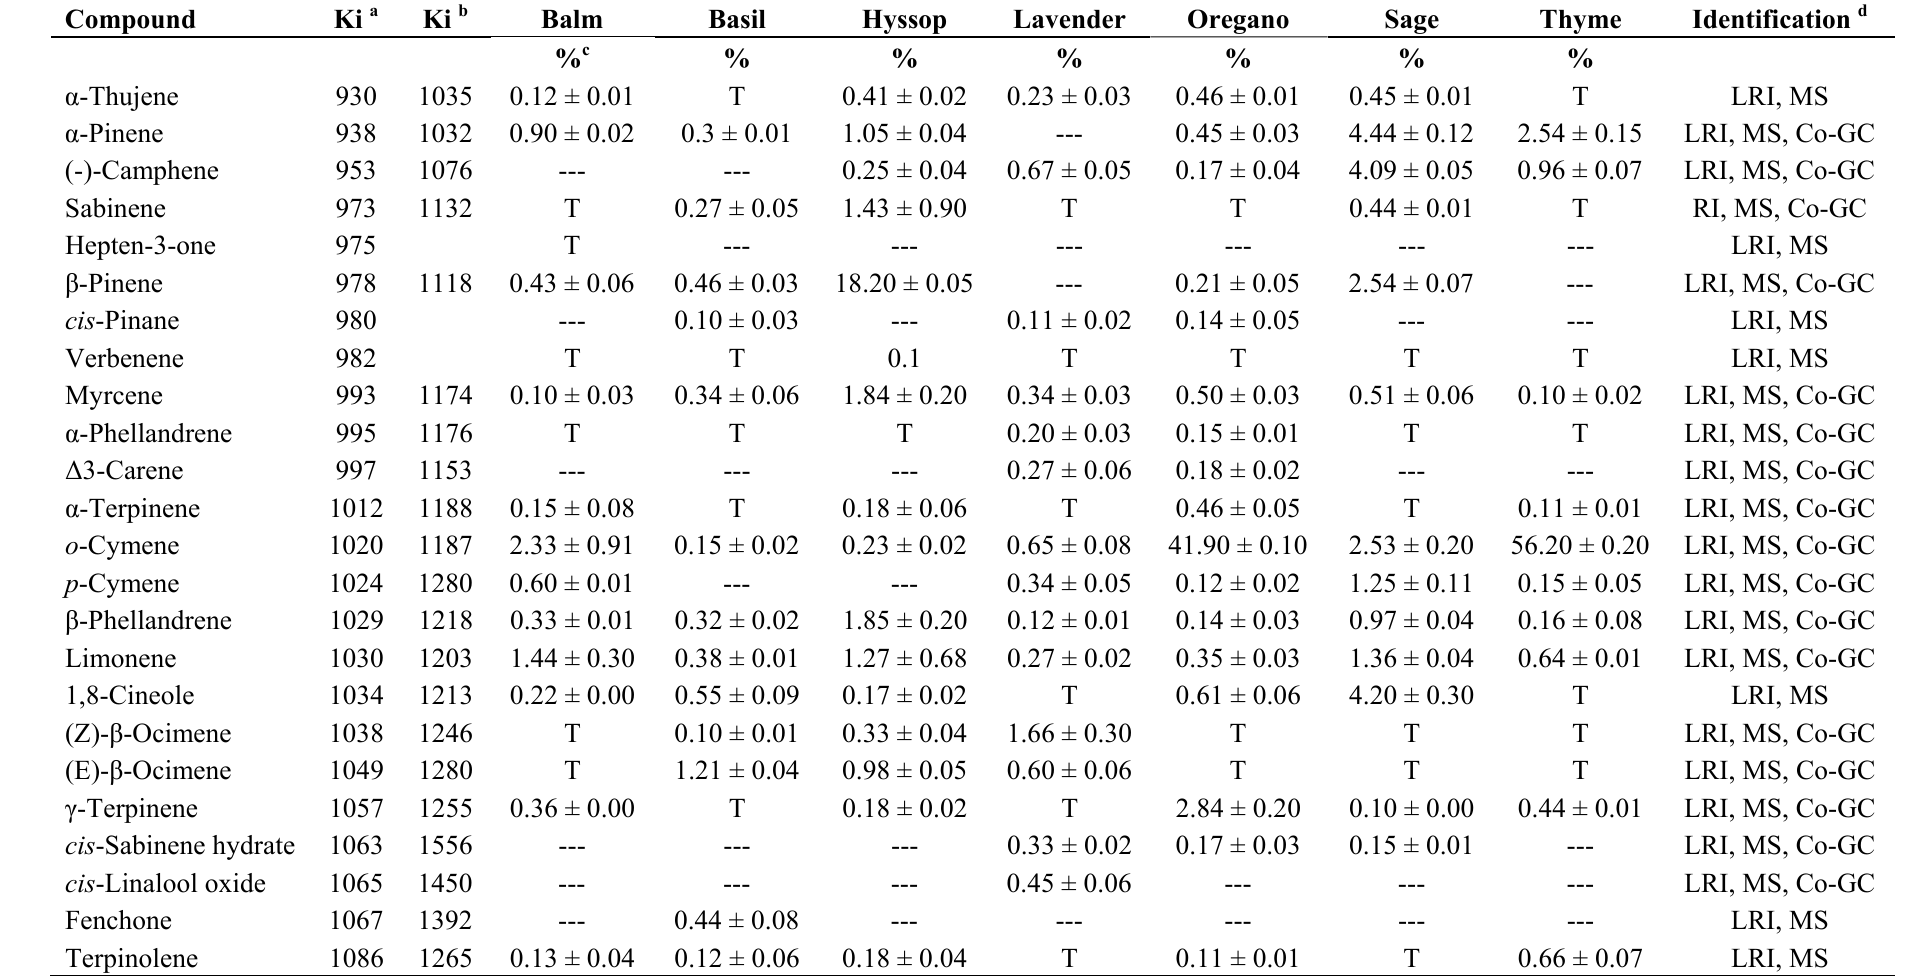
Table 1. Chemical composition of essential oils: Melissa officinalis L. (Balm), Ocimum basilicum L. (Basil), Hyssopus officinalis L. (Hyssop), Lavandula angustifolia Mill. (Lavender), Origanum vulgare L. (Oregano), Salvia officinalis L. (Sage), Thymus vulgaris L.